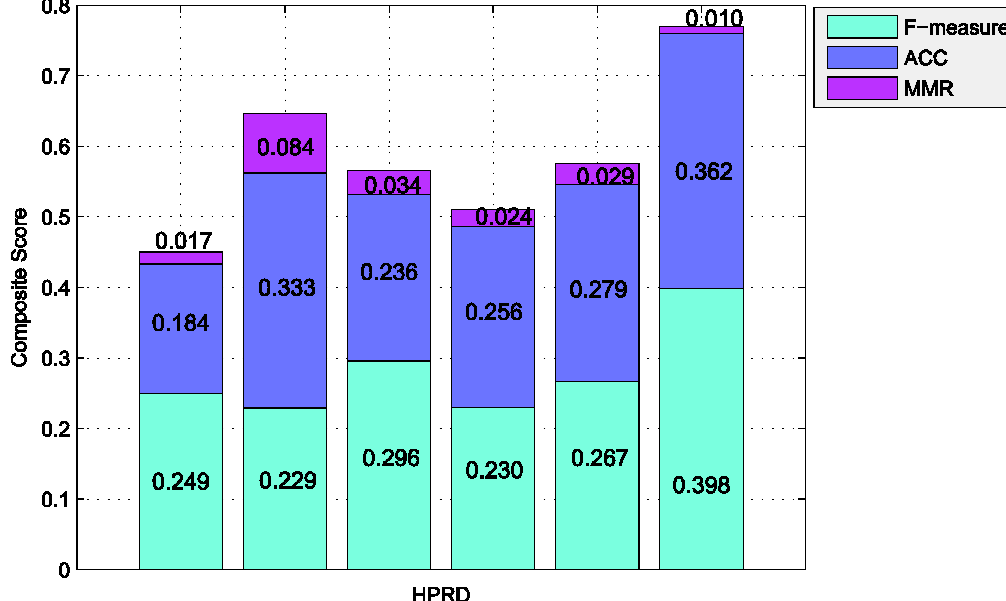
Figure 2. Results comparison of the six algorithms in HPRD dataset using CHPC2012 gold standard dataset. Columns correspond to the following algorithms, CFinder, ClusterONE, HC-PIN, PCE-FR, PMD and PMD pc from left to right. Various color of the same columns denotes the individual components of the composite score of the algorithm (cyan = F-measure, blue = ACC, and purple = MMR). The total height of each column is the value of the composite score for a special algorithm in a special dataset.